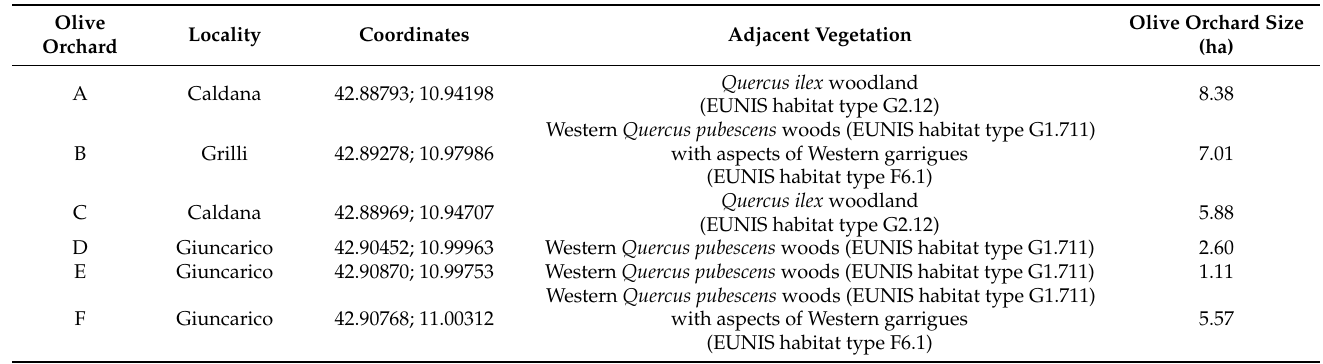
Table 1. Locality, coordinates, type of adjacent vegetation, altitude, and size of each sampled olive orchard (A–F). The vegetation is described according to EUNIS habitat nomenclature. For more details on vegetational features, see Table S1 in the Supplementary